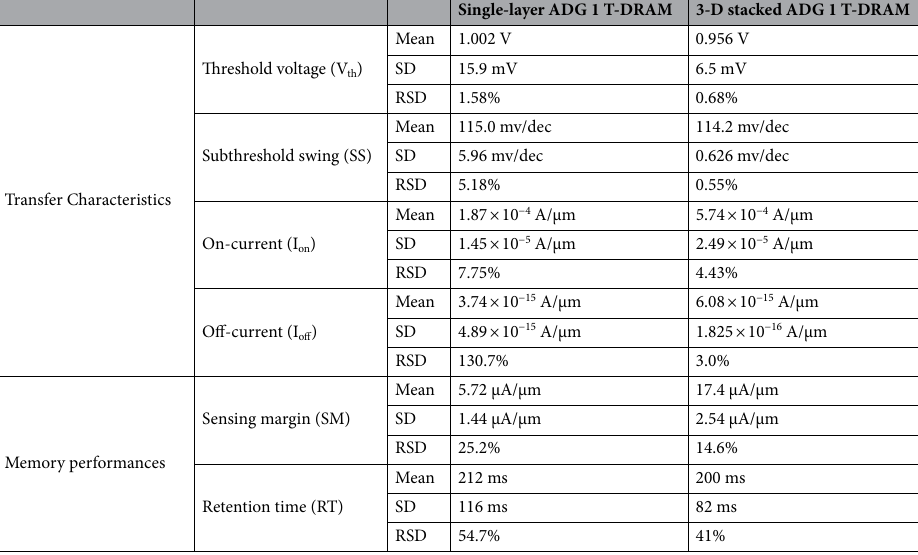
Table 4. Comparison of the mean, the SDs, and the RSDs of the transfer characteristics and the memory performances of the single-layer ADG 1 T-DRAMs and the 3-D stacked ADG 1